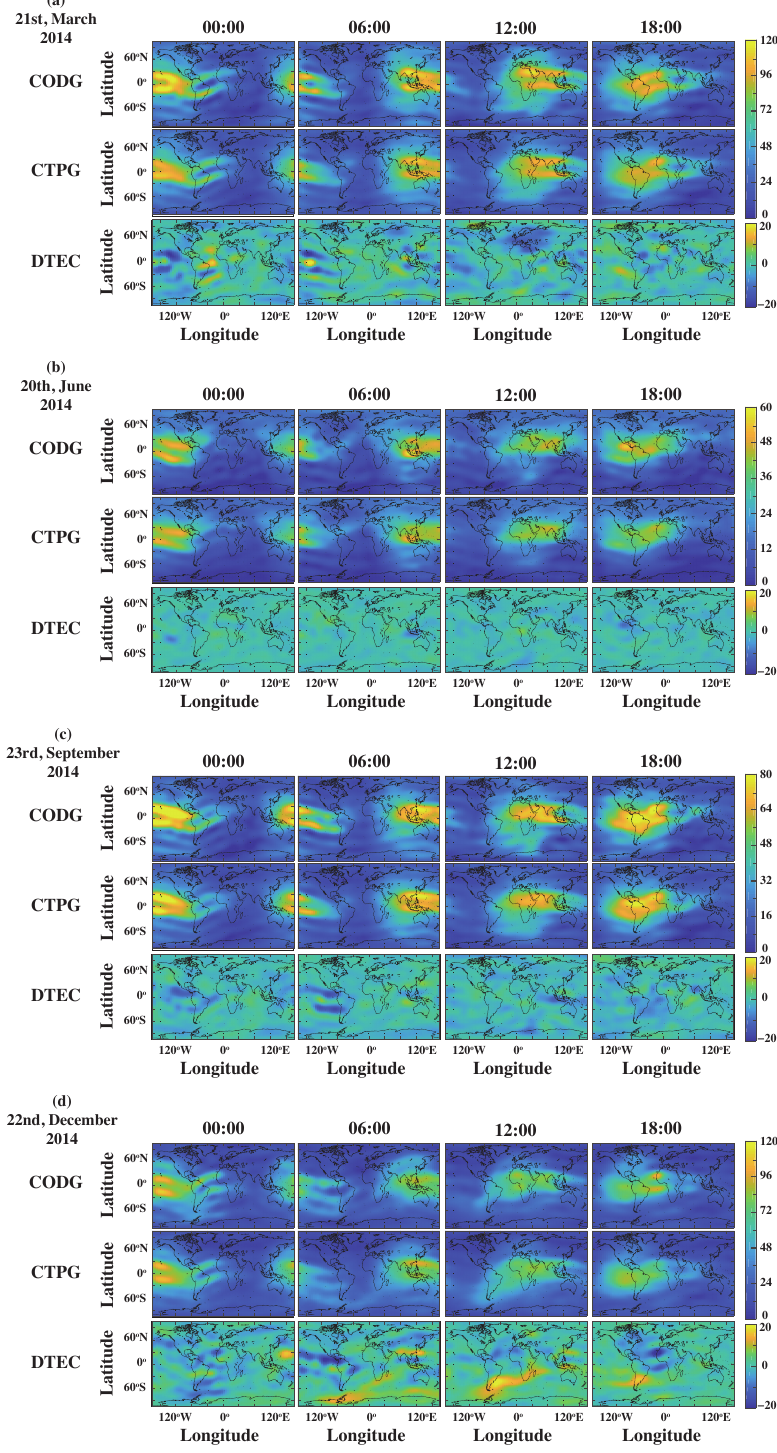
Figure 9. Comparison between the CTPG TEC maps and the CODE TEC maps at 00:00, 06:00, 12:00 and 18:00 UT on ( a ) 21 March 2014, ( b ) 20 June 2014, ( c ) 23 September 2014 and ( d ) 22 December